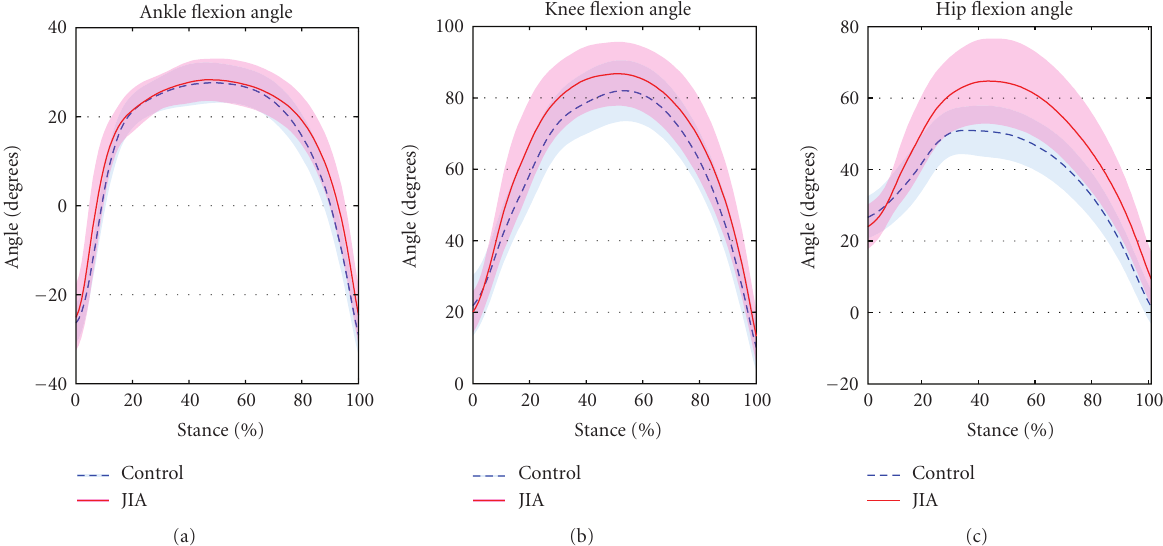
Figure 2: Ensemble averaged (mean ± 1 standard deviation) lower extremity joint angles during the drop vertical jump.